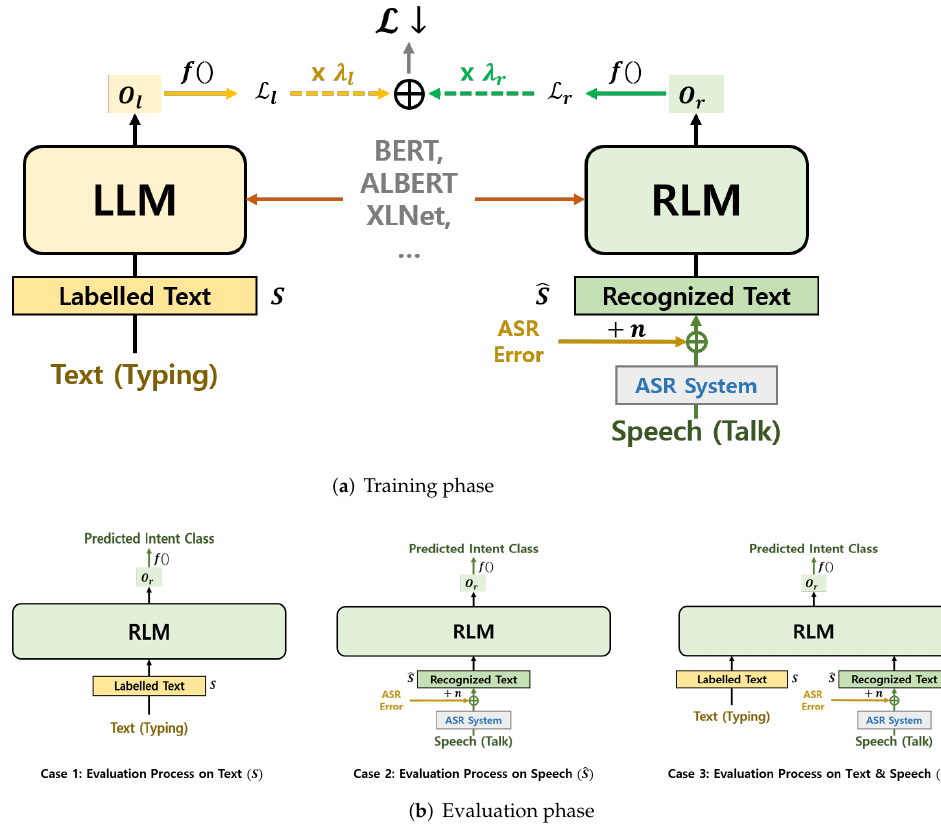
Figure 3. Model architecture of our proposed model. The training phase of our model shown in ( a ) uses the labeled text and recognized text jointly to train the users’ intents. In the evaluation process, we only use the RLM to find optimal users’ needs as illustrated in ( b ). As shown in ( b ), the input of the proposed model can be any combination of text and voice (recognized